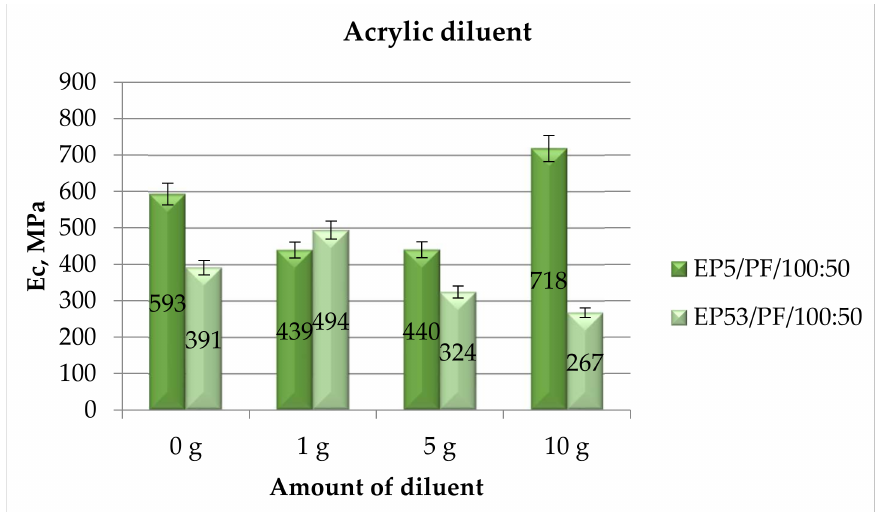
Figure 8. Compressive modulus calculated for Epidian 5 and Epidian 53 epoxy compounds as a function of the amount of acrylic diluent.